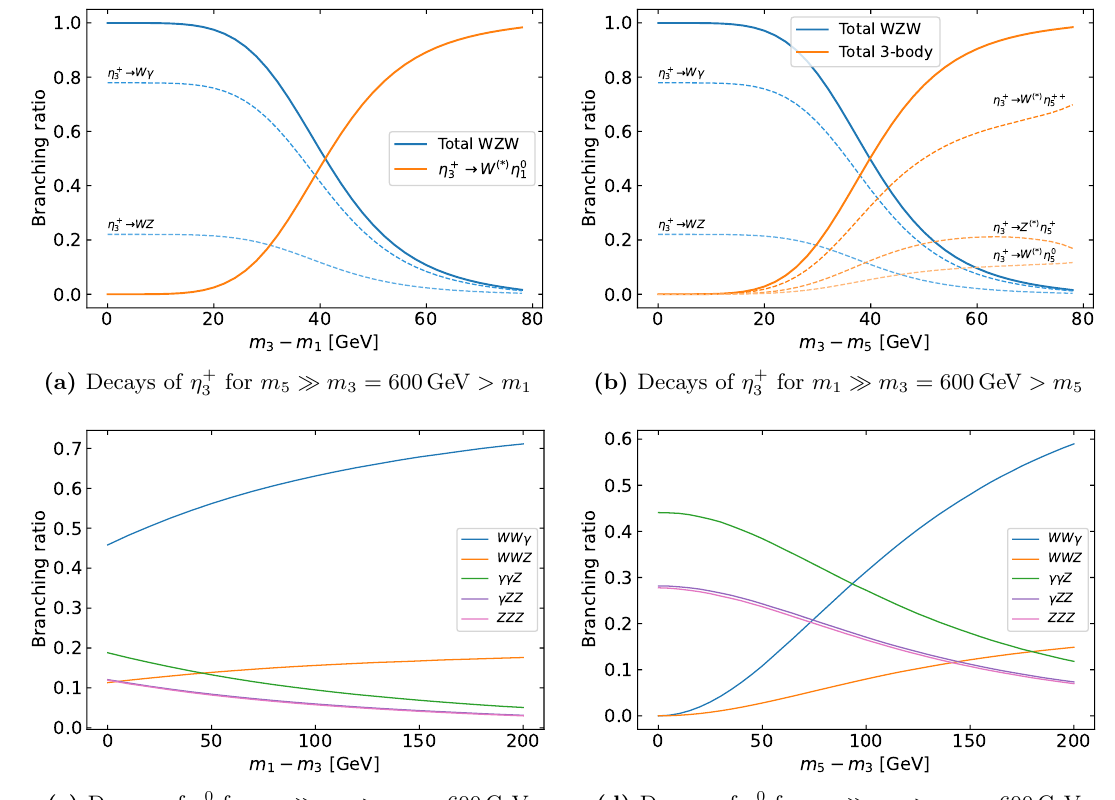
for m 1 (cid:29) m 3 = 600 GeV > m 5 3